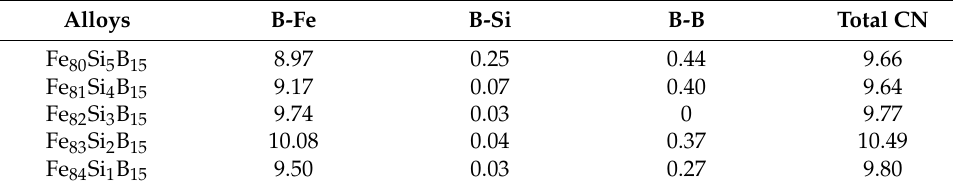
Table 4. B-centered total and partial CNs in the Fe 80+x Si 5 − x B 15 ( x = 0–4) alloys. Alloys B-Fe B-Si B-B Total